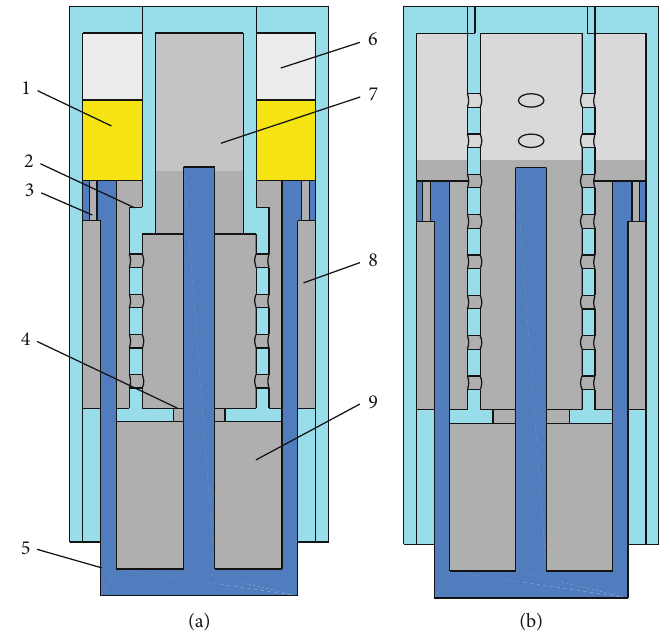
Figure 1: Structure diagram of shock absorber.